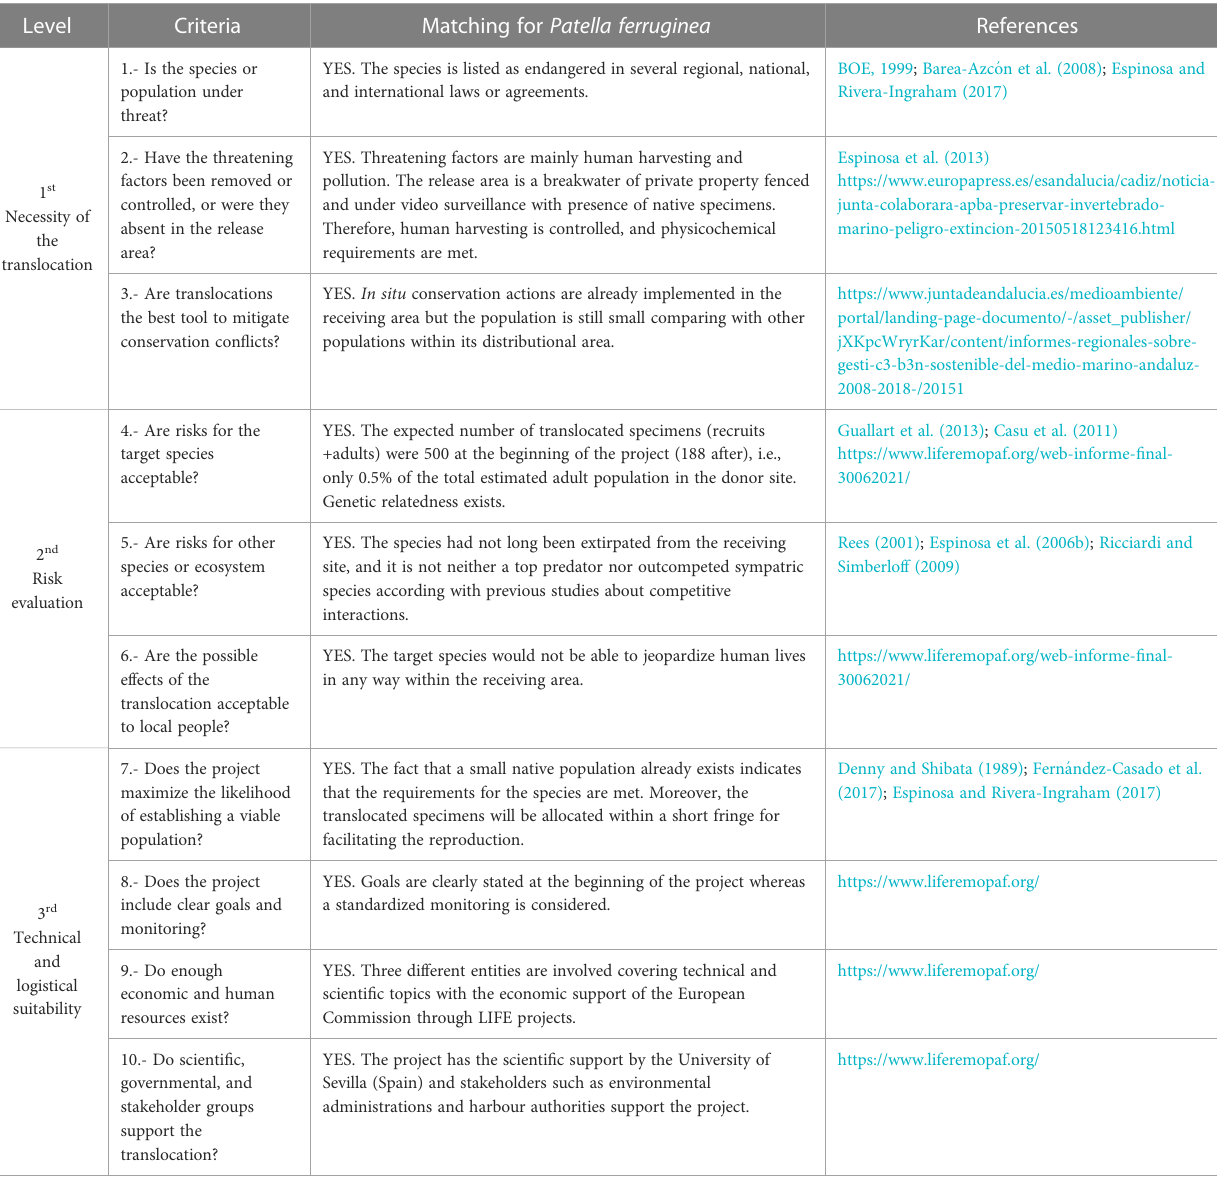
TABLE 1 Matching criteria for translocations (adapted from Pe ́ rez et al., 2012 based on IUCN guidelines and already published literature). Level Criteria Matching for Patella